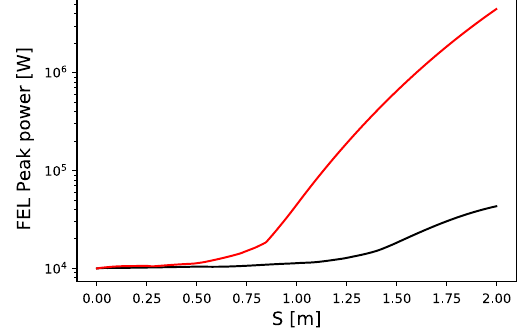
FIG. 7. FEL peak power at 200 nm along the undulator with a (black) 1 pC and (red) 5 pC per % of energy bandwidth. Beam transport simulation with GENESIS without collective effects